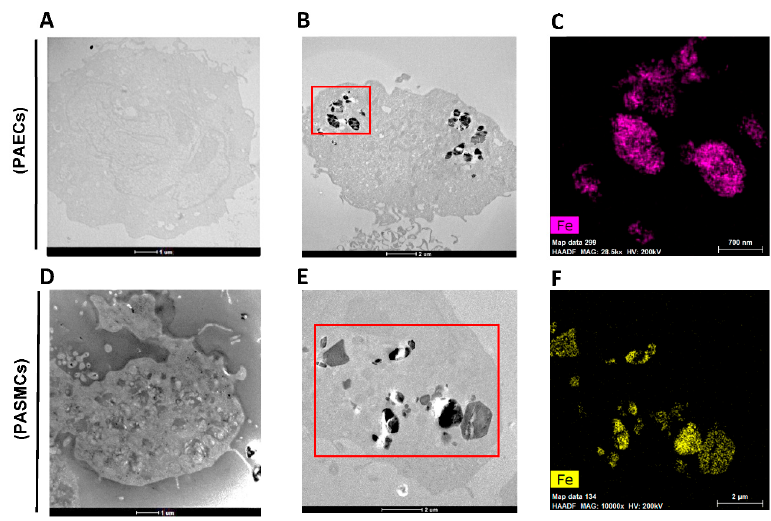
Figure 9. Scanning Transmission Electron Microscope images of PAECs and PASMCs treated with 5 µ g / mL nanoMIL-89. Cells embedded in Epoxy resin sections (around 100 nm) showing ( A ) an empty PAECs (scale bar = 1 µ m), ( B ) nanoMIL-89 incorporated in PAECs (scale bar = 2 µ m) and ( C ) energy dispersive spectroscopy (EDS) elemental mapping showing iron distribution inside the nanoMIL-89-treated sections (red square) of ( B ) PAECs (scale bar = 700 nm). ( D ) empty PASMCs (scale bar = 1 µ m), ( E ) nanoMIL-89 incorporated in PASMCs (scale bar = 2 µ m), and ( F ) EDS elemental mapping showing iron distribution inside the nanoMIL-89-treated sections (red square) of ( E ) PASMCs (scale bar = 2 µ